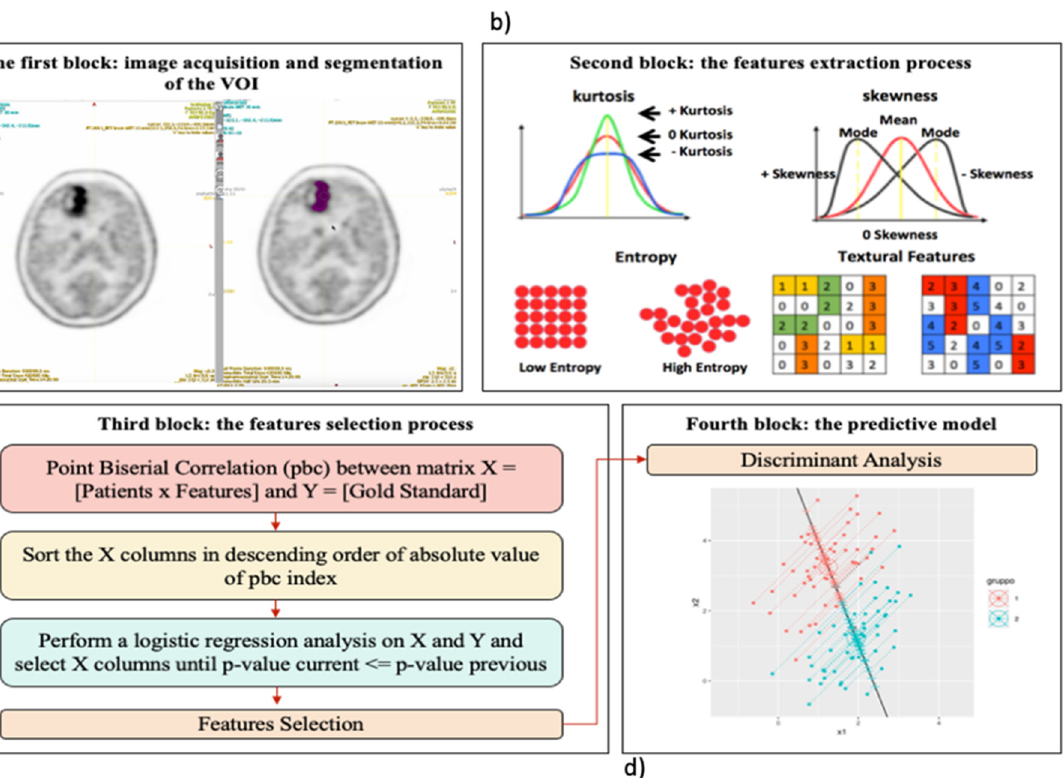
Figure 1. The radiomics workflow of the study. ( a ) PET image with lesion segmentation based on the thresholding method (see Section 2.1). ( b ) Some examples of the 44 features extracted using LifeX software, such as kurtosis, skewness, entropy and two textural features in the form of matrix (see Section 2.2), ( c ) Feature selection using a mixed descriptive-inferential sequential approach (see Section 2.2.3), ( d ) Representative figure of biplanar feature classification (low and high tumour grade) using the discriminant analysis as the supervised classifier. Specifically, a set of labelled instances (low and high tumour grade) were used for training purpose. Successively, the classifier was used to predict the label in the test set, where instances were without corresponding labels (see Section 2.2.4).